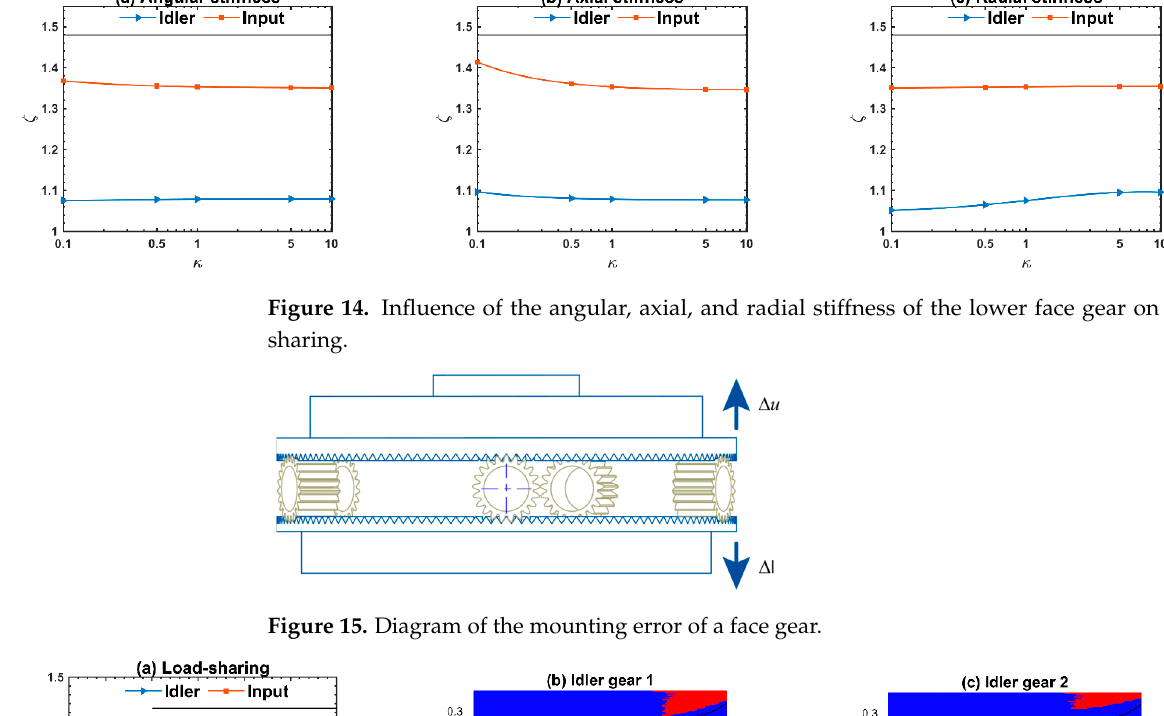
Figure 13. Influence of the angular, axial, and radial stiffness of the upper face gear on the load sharing.